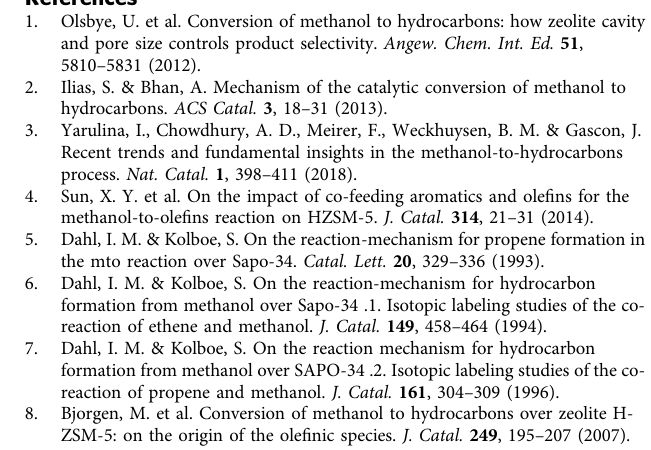
concentration on catalyst